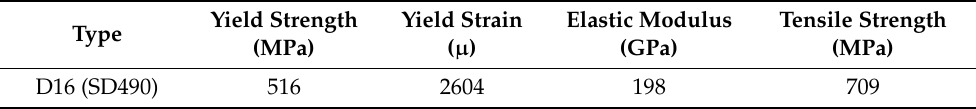
Figure 9. Casting method of FRCC. Table 4. mechanical properties of steel rebar.